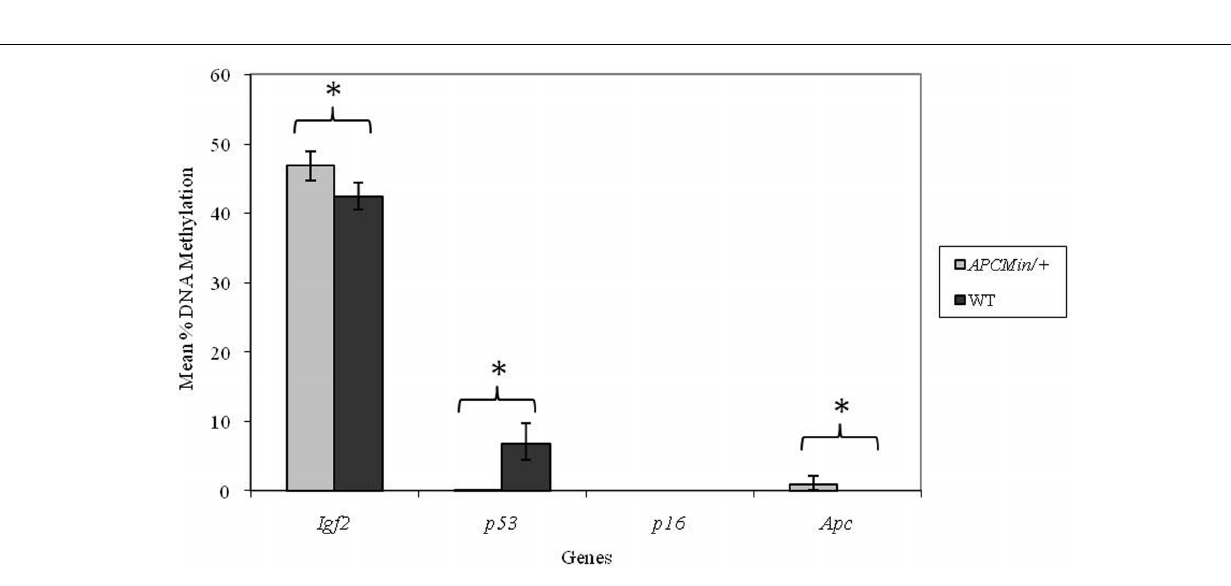
FIGURE 2 | Effect of genotype on gene-specific DNA methylation (%) in the proximal SI of adult mice (mean age 96days). Igf2 , n = 20 and 21; p53 ,